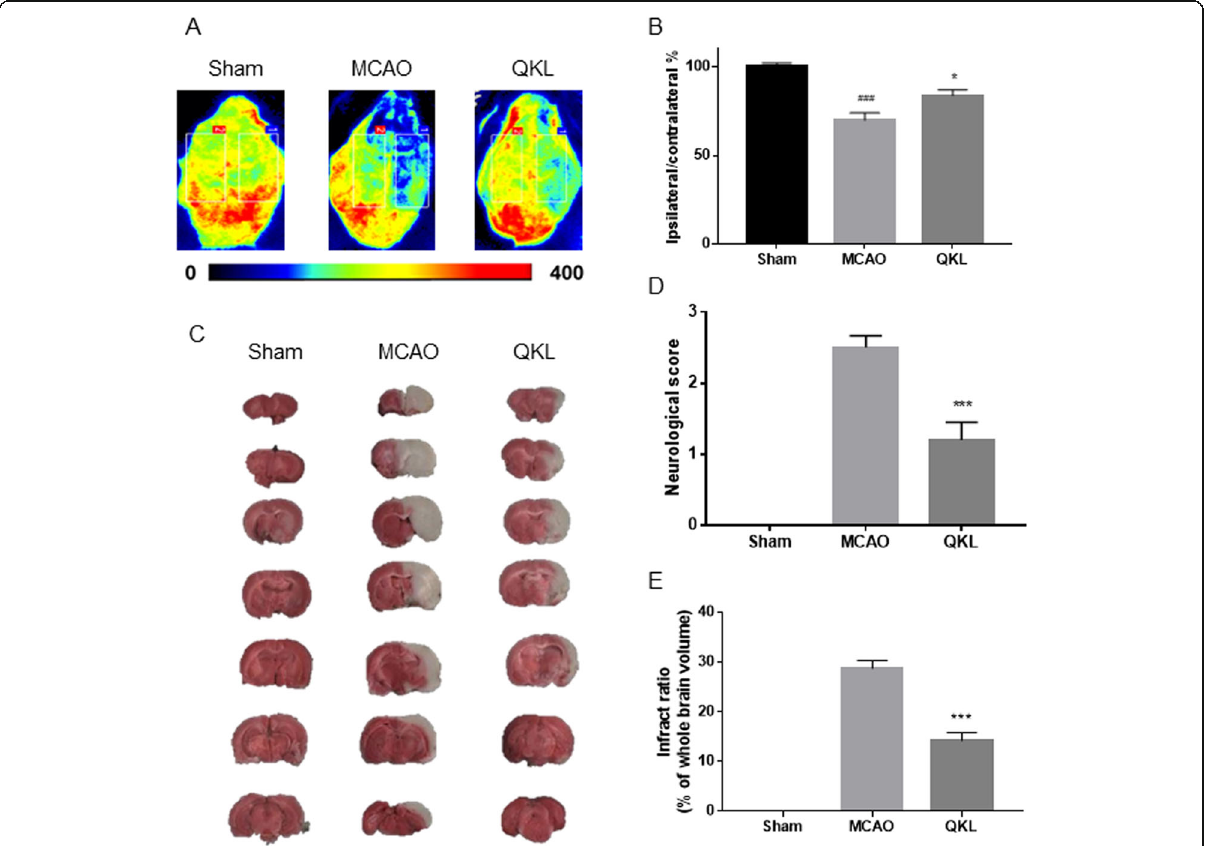
Fig. 1 Effects of Qingkailing (QKL) injection on ischemic injury in vivo. a Effects of QKL on region cerebral blood flow. b Quantitative analysis of regional cerebral blood flow. c Representative pictures of brain sections stained with 2% TTC. d Effect of QKL on neurological deficit scores. e Quantitative analysis of cerebral infarct volume. Data points indicate means ± SEM from 10 individual rats in each group. Vs Sham group, ### < 0.001, Vs MCAO group, * p < 0.05, *** p <